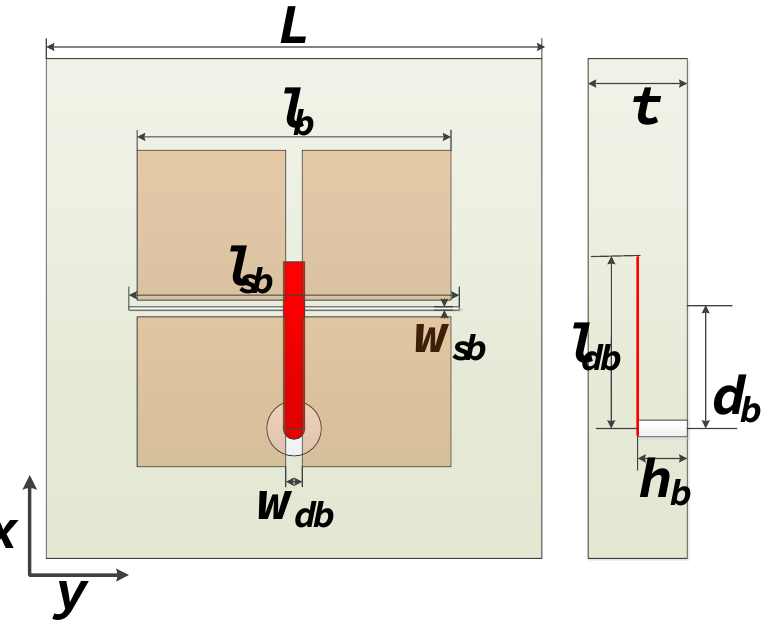
Figure 10. Geometry of antenna B.